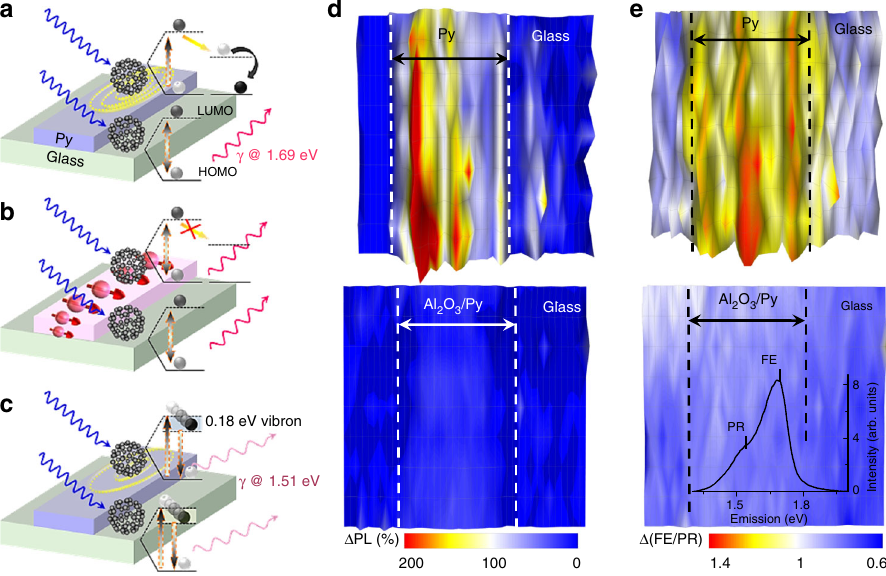
Fig. 5 PL in C 60 during spin pumping. Schematics for a . light exposure at 2.62 eV generates Frenkel excitons in C 60 that decay emitting photons at 1.69 eV. For molecules deposited on Py, the molecular dipole transfers energy to the metal leading to non-radiative decay (reduced PL); b during spin pumping the dipole-metal energy transfer is less ef fi cient, resulting in an increased PL for C 60 /Py; c the radiative decay of the molecular dipole can be promoted via phonon scattering with the Ag(2) vibron, emitting light at 1.51 eV. This process is less affected by the energy transfer or by spin pumping. d Photoemission in a 30-nm-thick C 60 fi lm for an area of 200 × 40 μ m 2 . The C 60 is deposited on a glass substrate and partly covered by a 100 μ m wide Py (top fi gures) or Al 2 O 3 /Py track (bottom). In d , we show the PL ratio on/off FMR (1.6 GHz resonance at 20 Oe). Compared to C 60 on glass, the photoemission intensity on the Py track has increased on average 100% during spin pumping. For the sample with a 2 nm alumina barrier the change is of only 12%. e . Ratio of Frenkel exciton to phonon replica photoemission (1.69 vs. 1.52 eV) on/off FMR. This ratio is enhanced by 21% on the Py track during spin pumping. For the Glass/C 60 /Al 2 O 3 /Py sample, no signi fi cant changes are observed. Inset shows the PL spectra of the C 60 fi